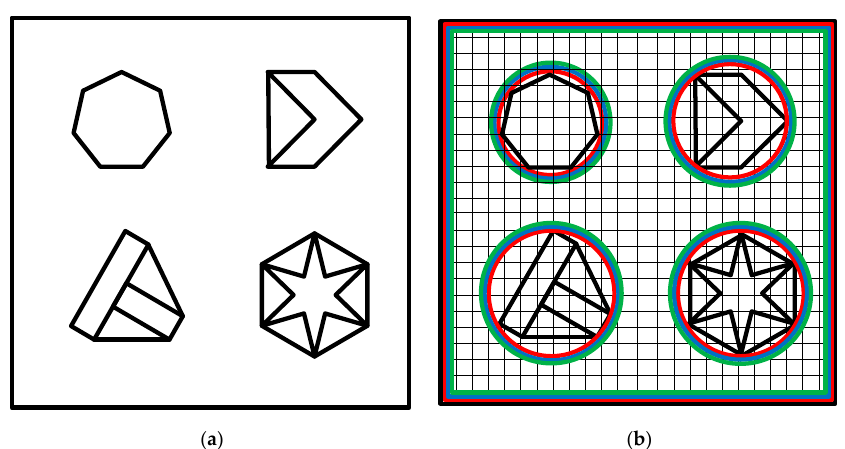
Figure 1. ( a ) Environmental map information; ( b ) expansion logic operation for obstacles.